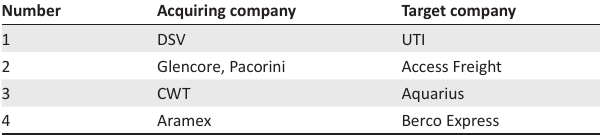
TABLE 3: The four participating companies (acquiring and